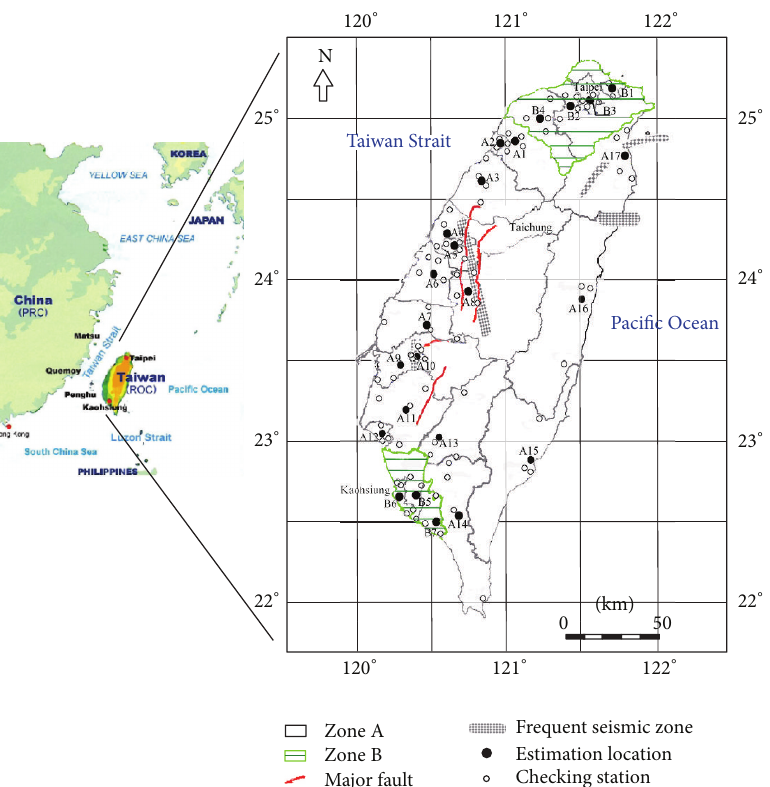
Figure 1: Sketch of the research area and seismic subdivision zone. (http://www.unc.edu/depts/diplomat/item/2010/0912/comm/norris